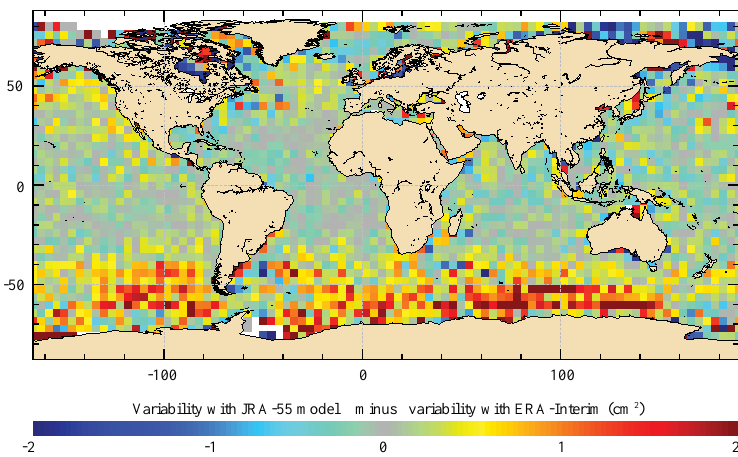
Figure 5. Change in crossover differences between processing TOPEX/Poseidon mission with IB calculated using JRA-55 or ERA-Interim. Positive values indicate greater variance with corrections from